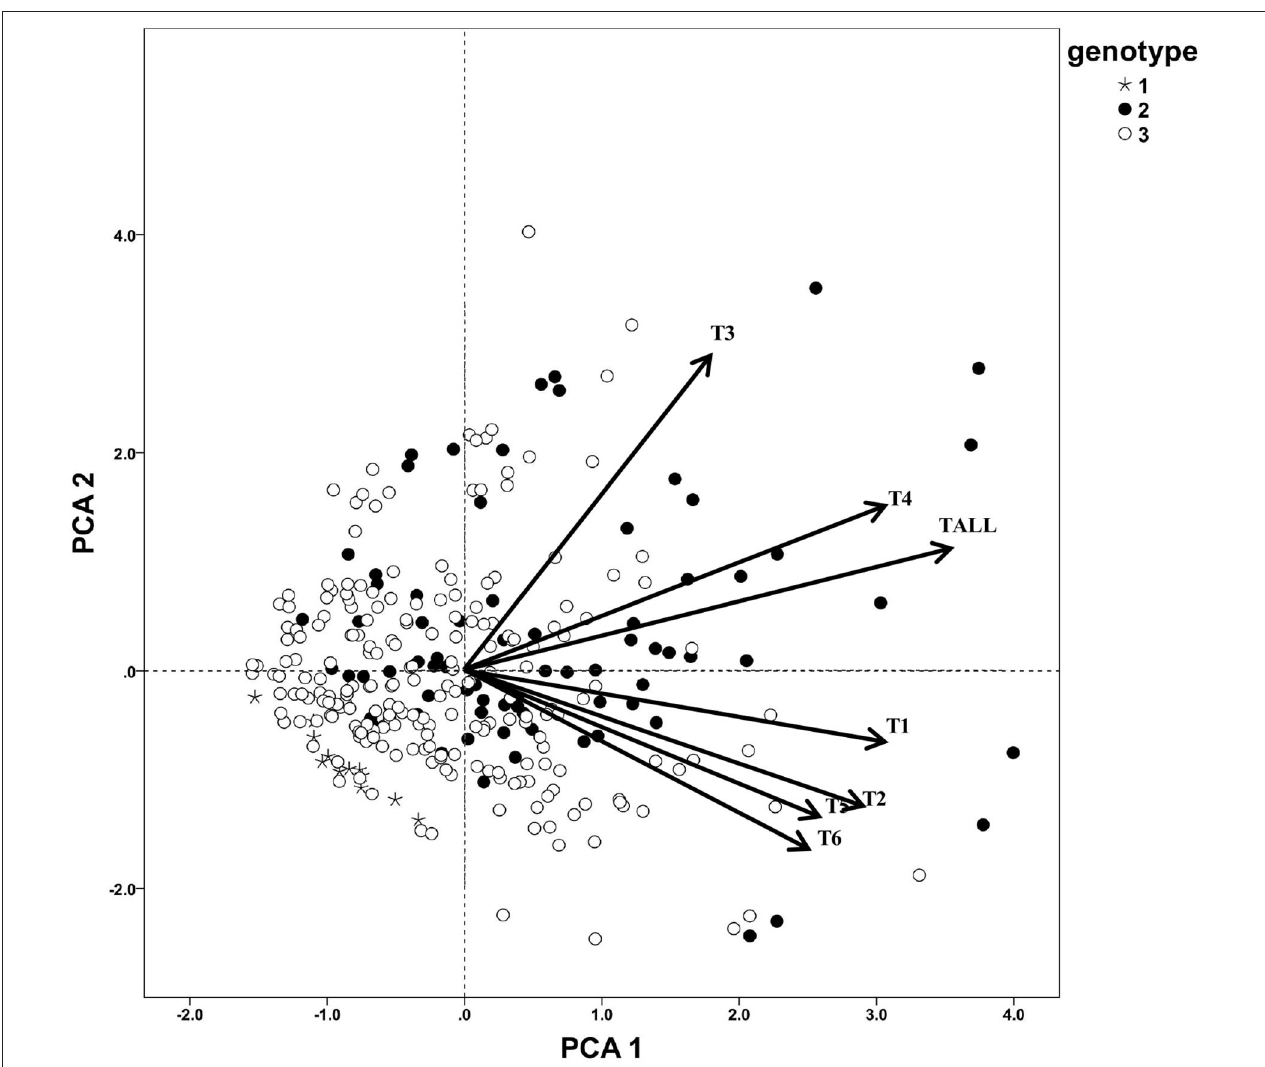
FIGURE 4 | Principal component analysis of triterpenoids of C. paliurus genotypes. T1, arjunolic acid; T2, cyclocaric acid B; T3, pterocaryoside B; T4, pterocaryoside A; T5, hederagenin; T6, oleanolic acid; Tall, total